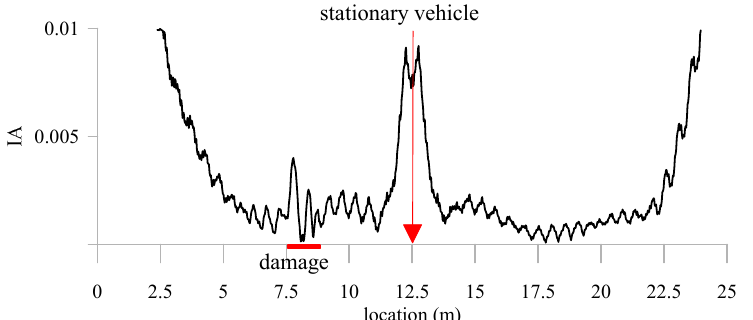
Figure 12. IA of IMF of the contact-point response of a stationary vehicle with 5 m/s speed of the moving vehicle.